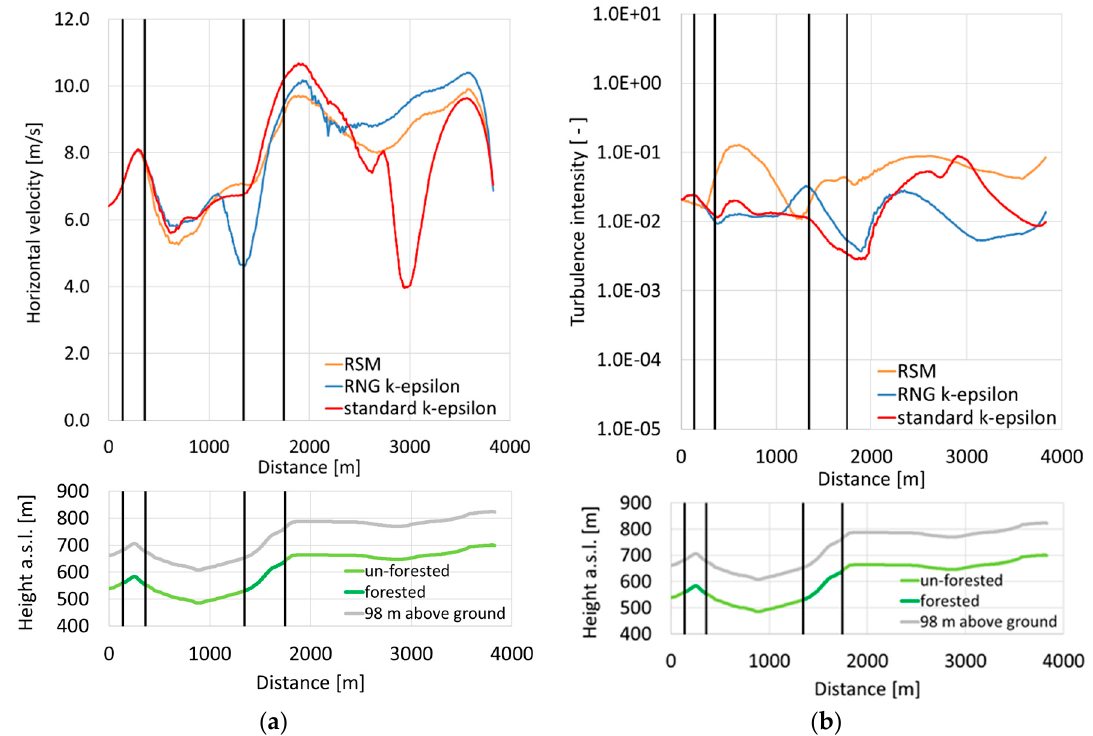
Figure 8. ( a ) Horizontal velocity at a constant distance of 98 m above the ground (grey line); ( b ) turbulence intensity at a constant distance of 98 m above the ground (grey line).